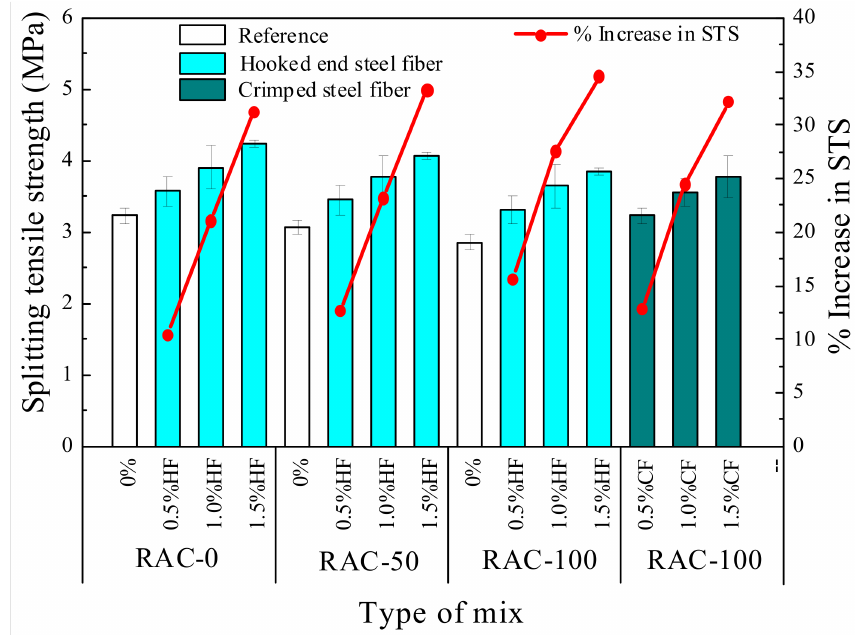
Figure 7. Splitting tensile strength of fiber-reinforced RAC